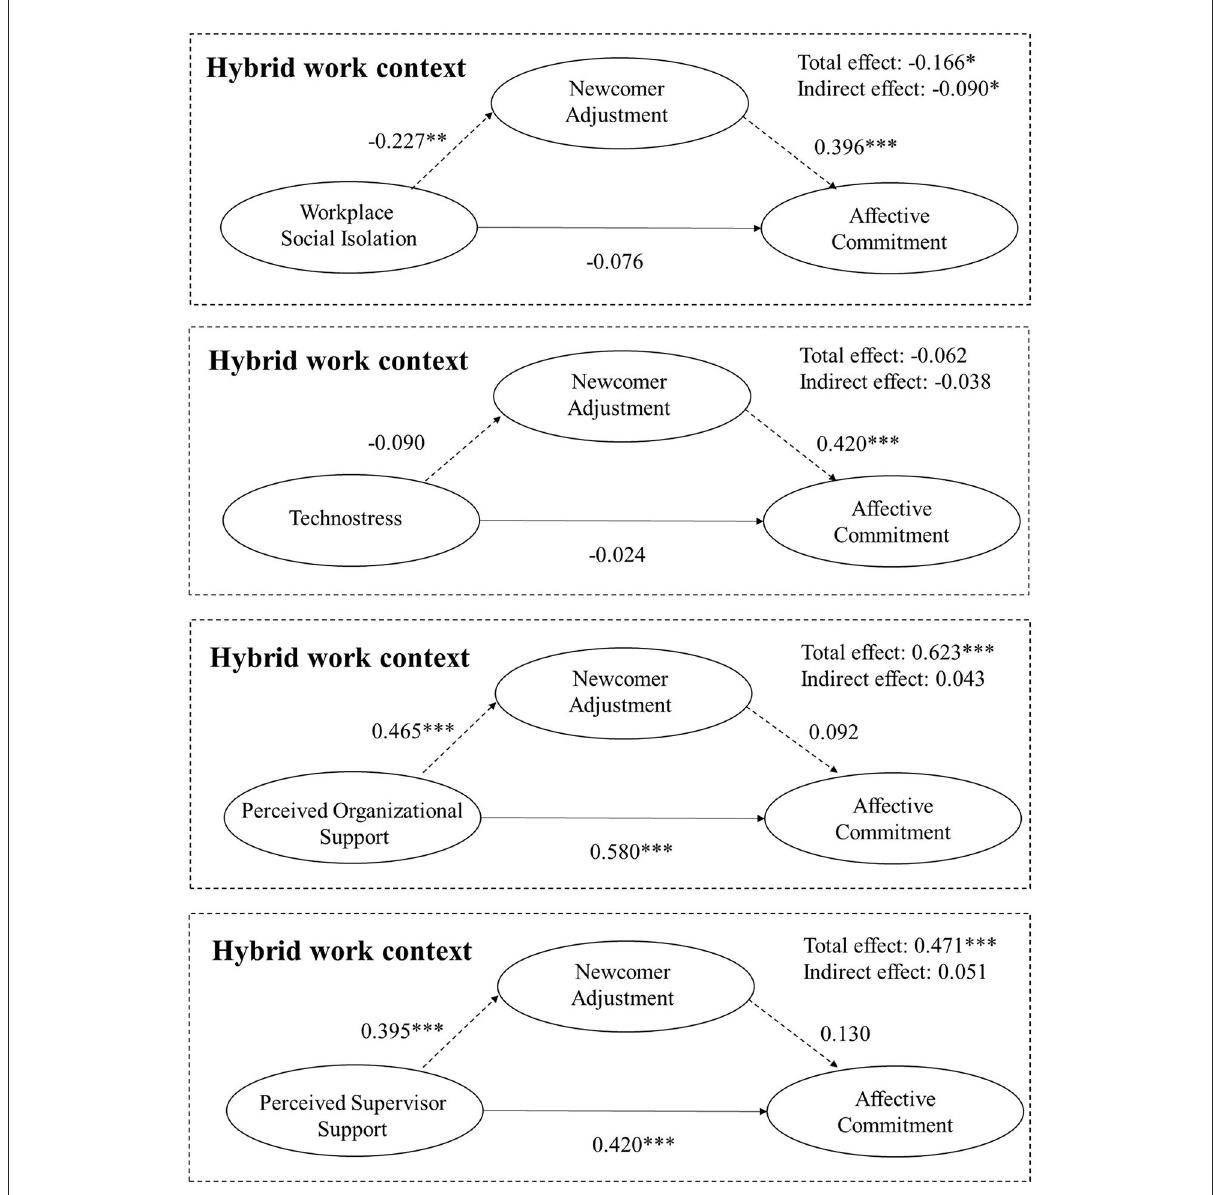
FIGURE3 Research model with unstandardized coefficients (H5–H8). Primary data. * p < 0.05, ** p < 0.01, *** p <